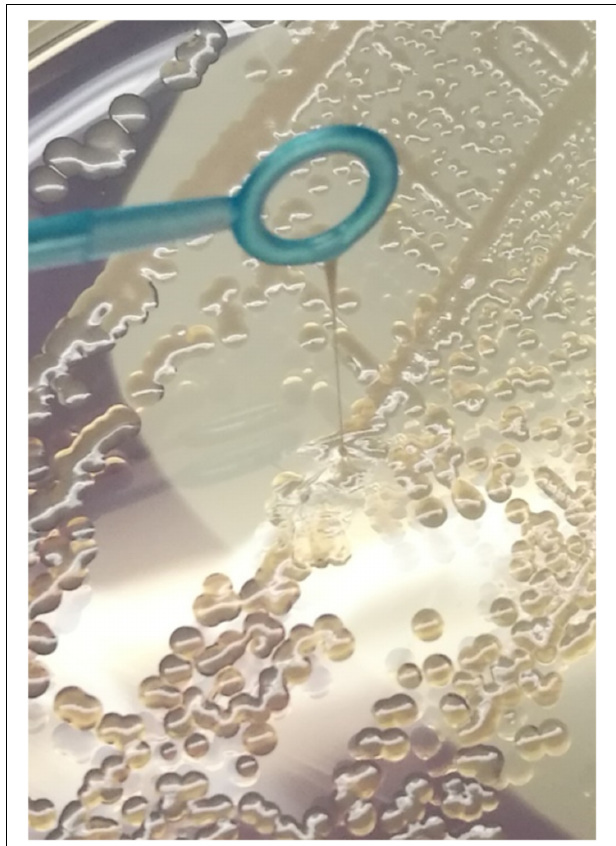
FIGURE 1 | Escherichia coli strain 26561 displays a strong “string” effect representative of hypermucoviscosity. This phenotype was evident on all agar media on which this strain was grown and this is a representative image from growth on LB agar.